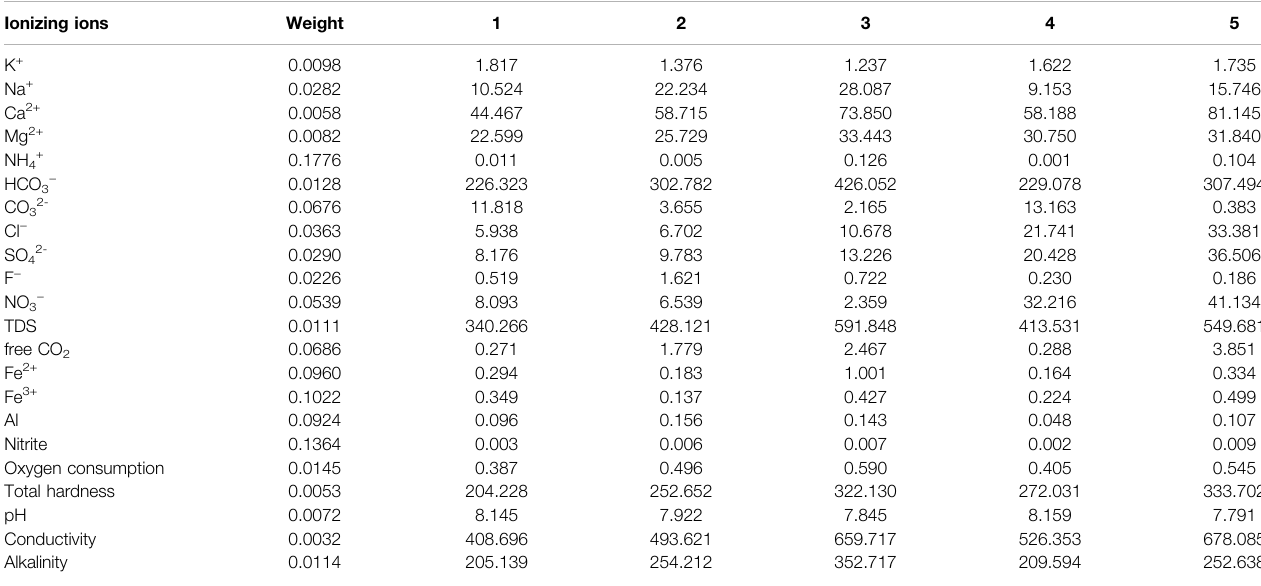
TABLE 4 | Average concentrations of cluster 1 to cluster 5 calculated by the entropy